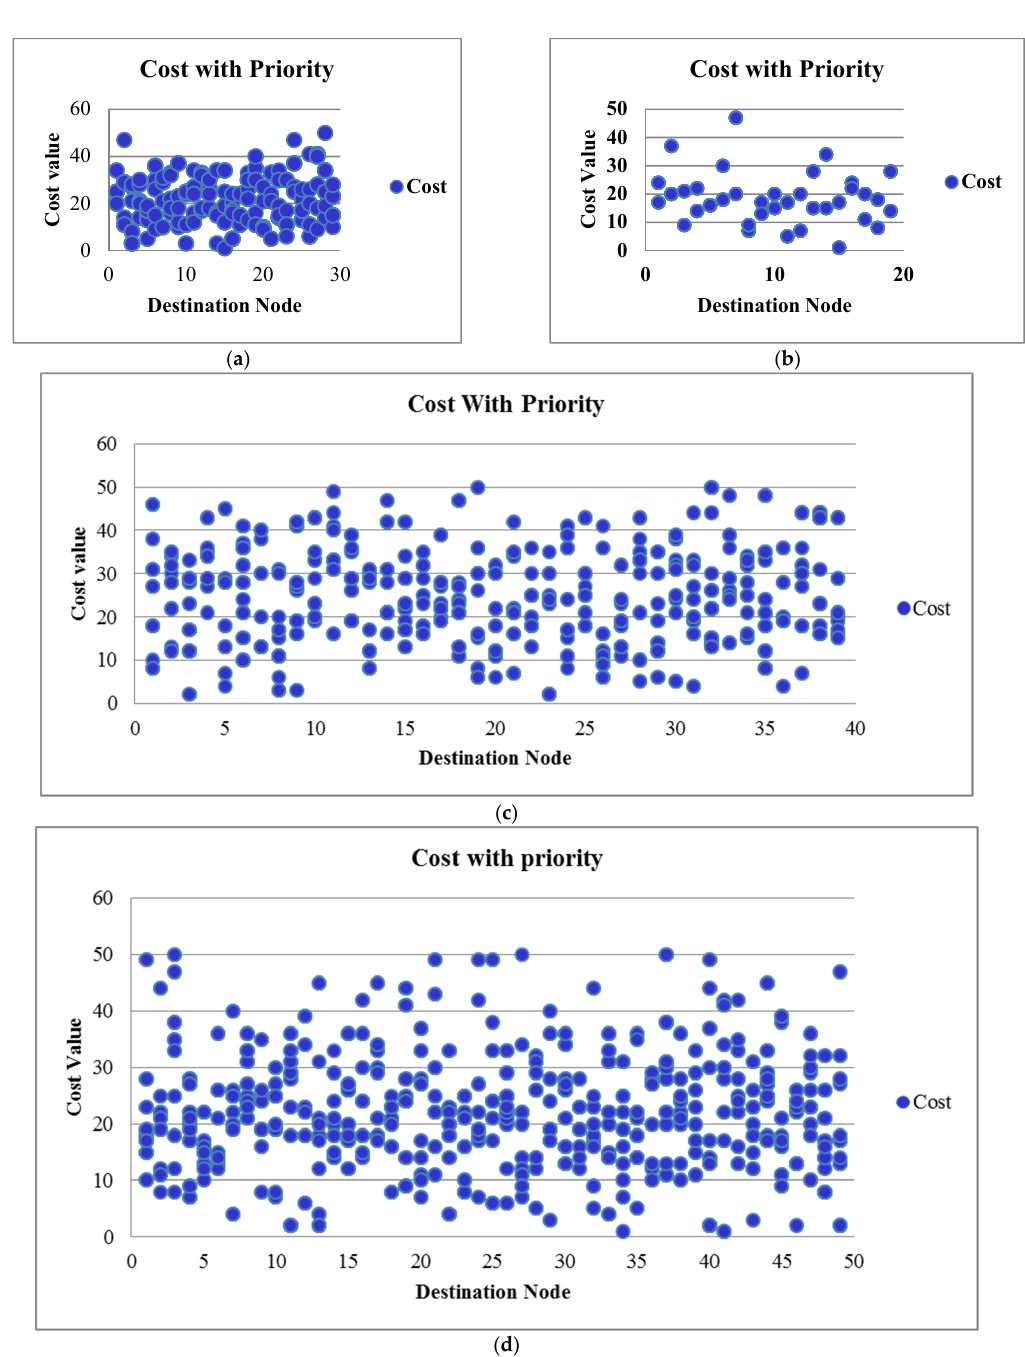
Figure 9. Constraint values that can produce efficient paths with priority. ( a ) Available paths with 20 nodes; ( b ) available paths with 30 nodes; ( c ) available paths with 40 nodes; ( d ) available paths with 50